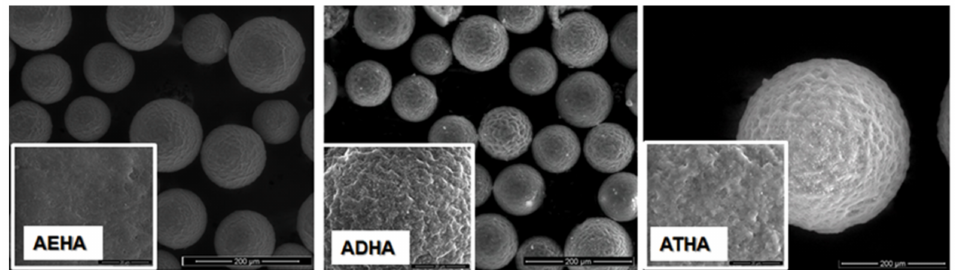
Figure 6. SEM micrographs of precursor microparticles.